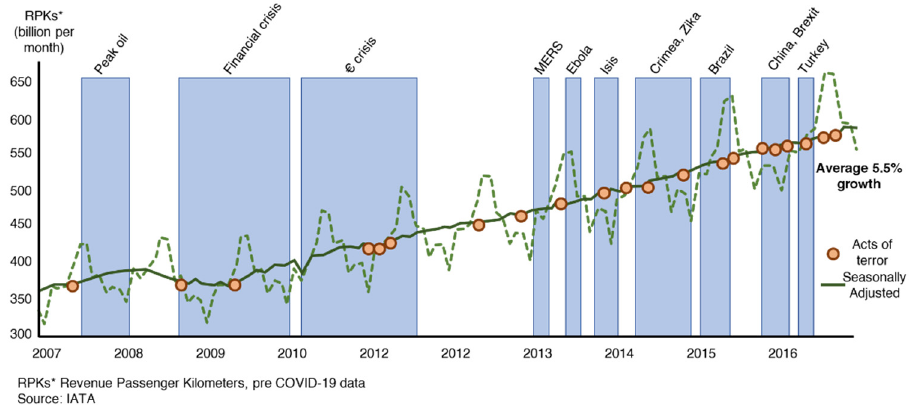
Figure 1. Revenue Passenger Kilometers (RPK) of the last decade, elaboration from [1].